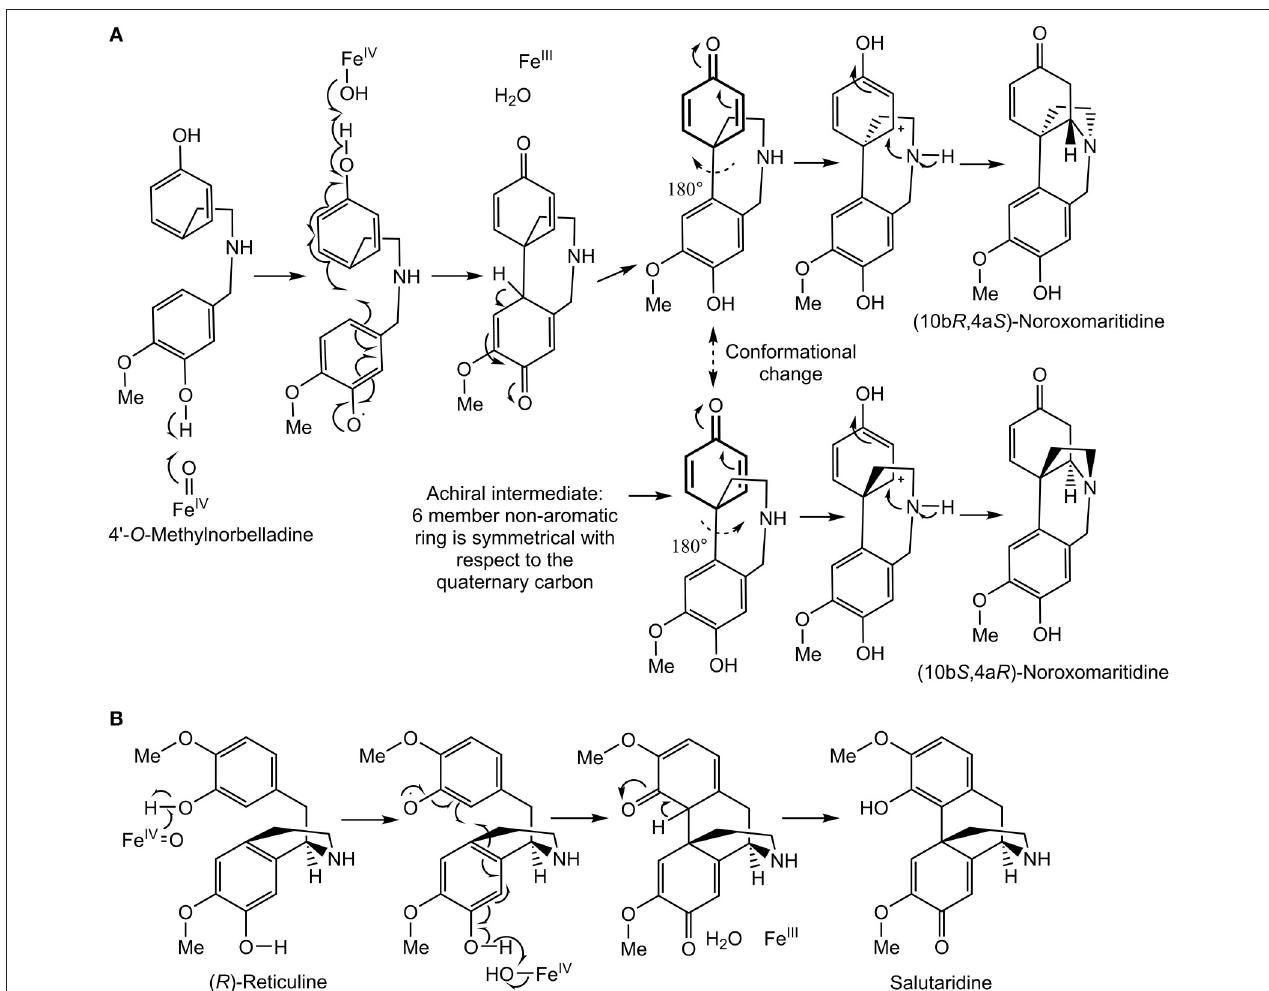
FIGURE 9 | Proposed C-C phenol coupling mechanisms. (A) 4 ′ - O -methylnorbelladine para-para’ C-C phenol coupling mechanism followed by spontaneous nitrogen ring closure to form noroxomaritidine. (B) ( R )-reticuline para-ortho’ C-C phenol coupling mechanism to form salutaridine panel adapted from Grobe et al. (2009)